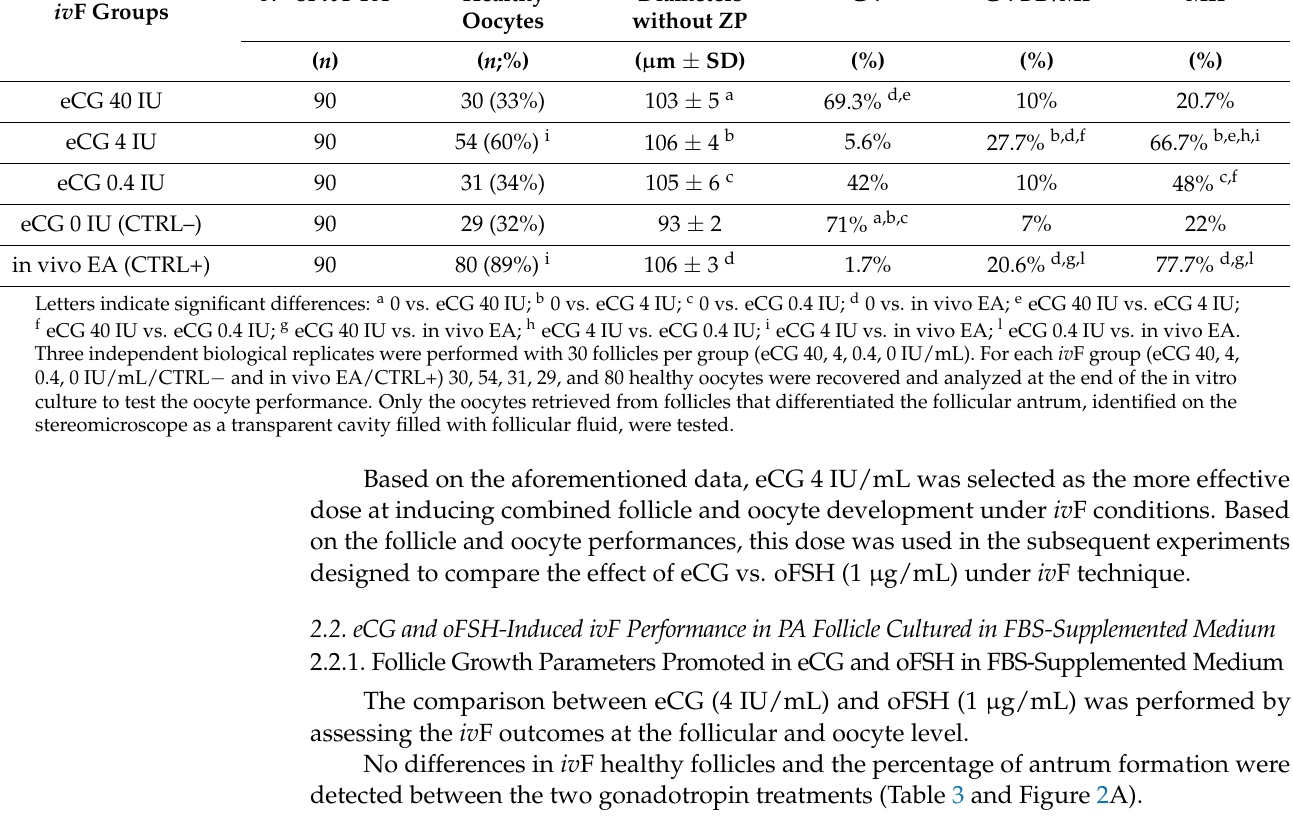
Table 3. eCG and oFSH effect on iv F outcomes: quantitative and qualitative PA follicle performances in FBS-supplemented medium.